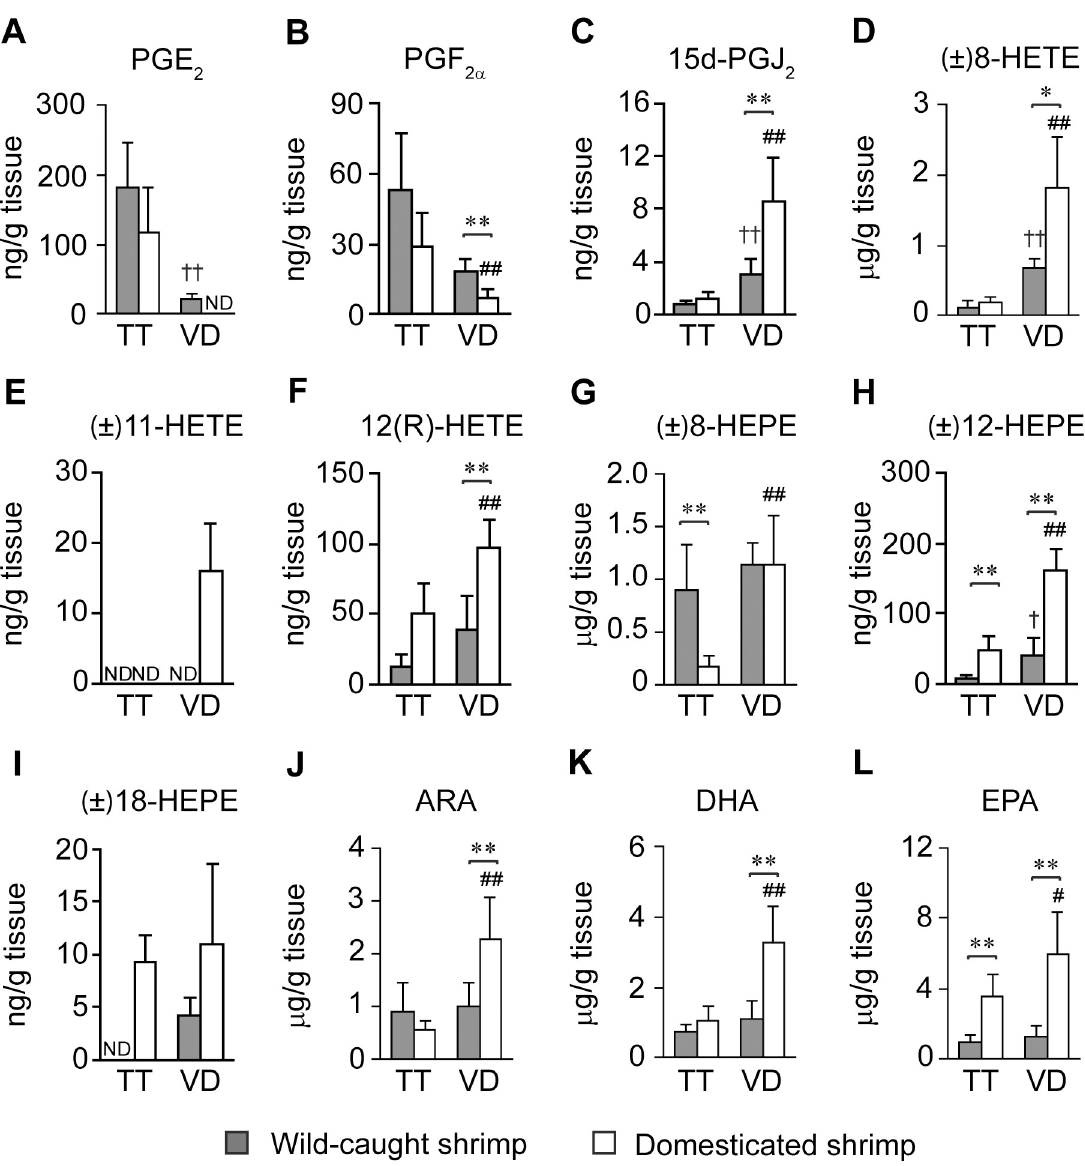
Fig 5. Quantitative analysis of eicosanoids and PUFAs in testes and vas deferens of wild-caught and domesticated P . monodon . Levels of (A) PGE 2 , (B) PGF 2 α , (C) 15d-PGJ 2 , (D) ( ± )8-HETE, (E) ( ± )11-HETE, (F) 12(R)-HETE, (G) ( ± )8-HEPE, (H) ( ± )12-HEPE, (I) ( ± )18-HEPE, (J) ARA, (K) DHA, and (L) EPA in testes (TT) and vas deferens (VD) were compared between wild-caught (gray bar, N = 6) and domesticated shrimp (white bar, N = 10). Data are shown as means ± SD. Asterisks indicate statistically significant differences in metabolic levels between wild-caught and domesticated shrimp using the t -test ( � for P < 0.05 and �� for P < 0.01). Daggers indicate statistically significant differences in metabolic levels between testes and vas deferens of wild-caught shrimp using the t -test († for P < 0.05 and †† for P < 0.01). Hashes indicate statistically significant differences in metabolic levels between testes and vas deferens of domesticated shrimp using the t -test (# for P < 0.05 and ## for P < 0.01). ND indicates that the designated metabolite was not detected in this